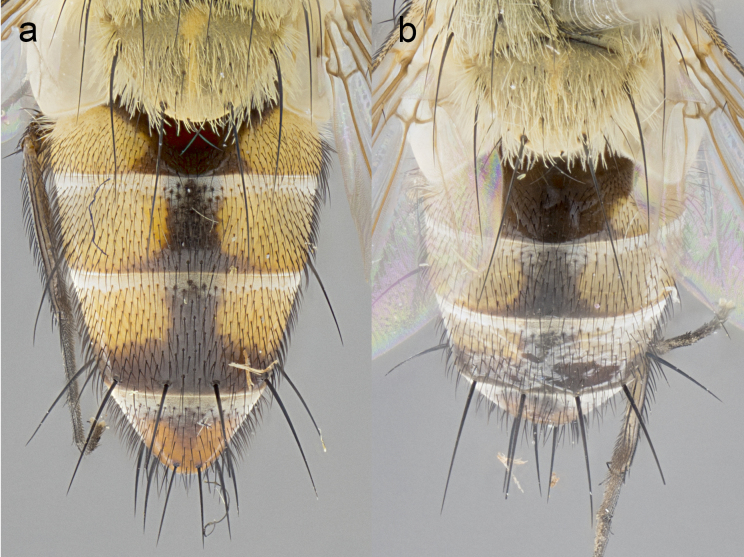
Detail showing difference in coloration of dorsomedial ST1+2; a.
Telothyria
aidani
sp. n.; b.
Telothyria
alexanderi
sp. n.